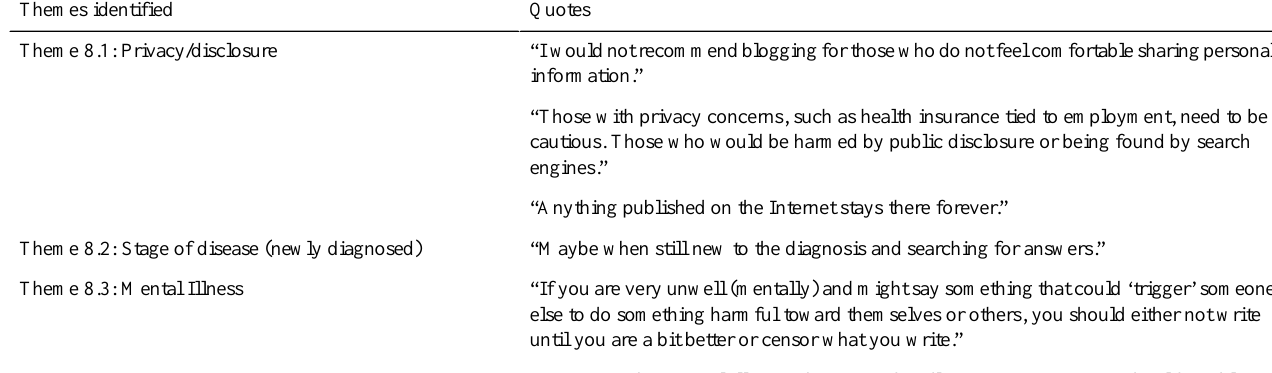
Table 10. Perceived situations in which blogging would not be recommended. QuotesThemes